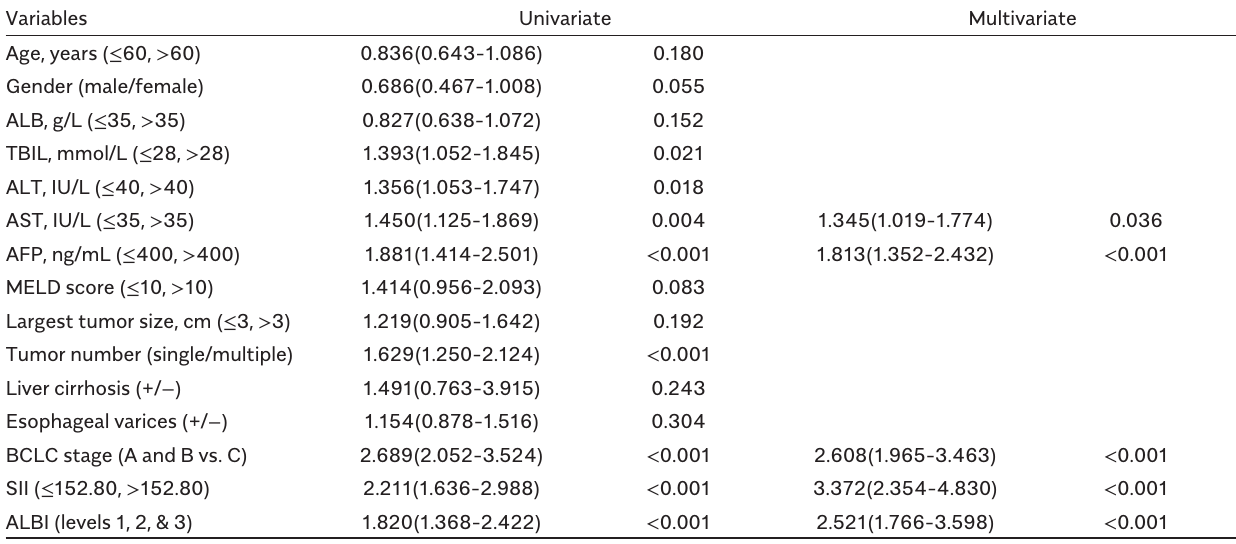
Table 3. Prognostic Factors Associated with